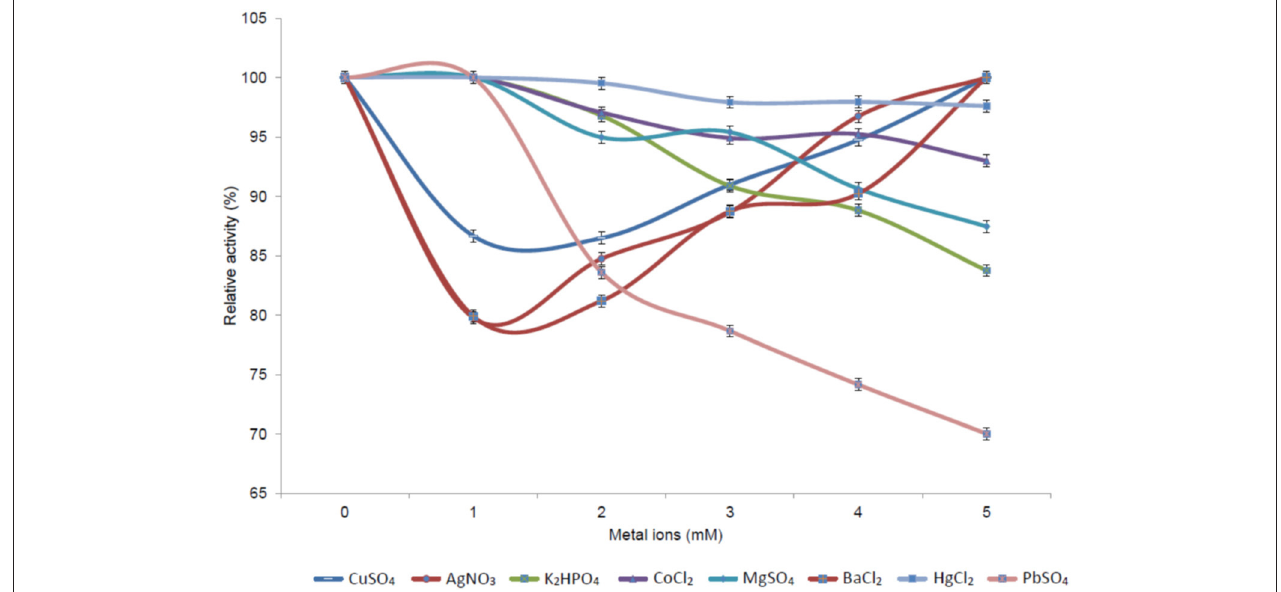
FIGURE 8 | Effect of different metal ion concentrations on the activity of the 7N9 esterase. The effect of various metals (Ag + , Cu 2 + , K + , Co 2 + , Mg 2 + , and Ba 2 + ) and heavy metals (Hg + and Pb 2 + ) at concentrations ranging from 1 to 5mM on 7N9 esterase activity was assessed. The values displayed are the means and standard deviations of triplicate measurements.